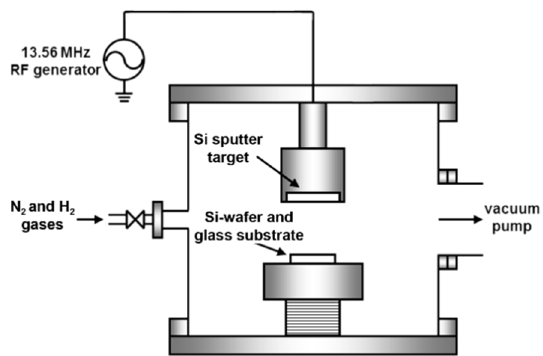
Figure 1. Schematic view of the sputtering system.